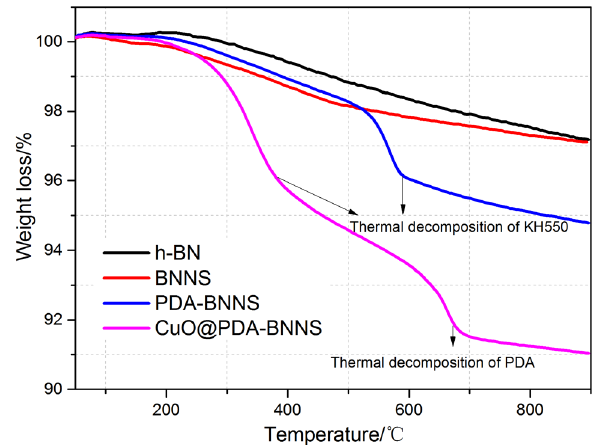
Fig.3 TGA curves of h-BN, BNNS, PDA-BNNS and CuO@BNNS